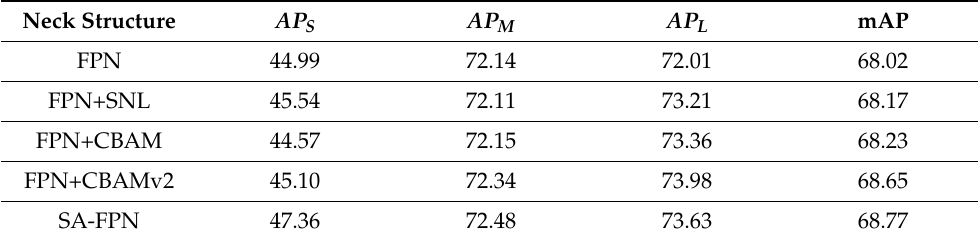
Table 1. The impact of different attention on FPN.